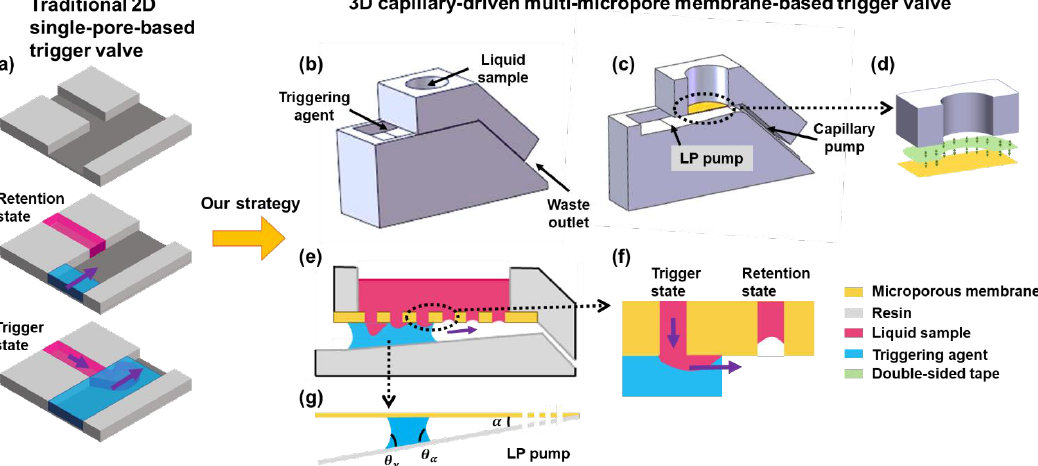
Figure 1. Schematic diagram showing the mechanics and mechanism of the 3D capillary-driven multi-micropore membrane-based trigger valve. ( a ) 3D Schematic and trigger process of traditional 2D single-pore-based trigger valve. ( b ) 3D Schematic of the 3D capillary-driven multi-micropore membrane-based trigger valve. ( c ) Vertical cross-section view of the 3D valve. ( d ) Device assembly schematic. ( e ) Working mechanism of the 3D valve. ( f ) Two states of micropores. ( g ) Laplace pump.